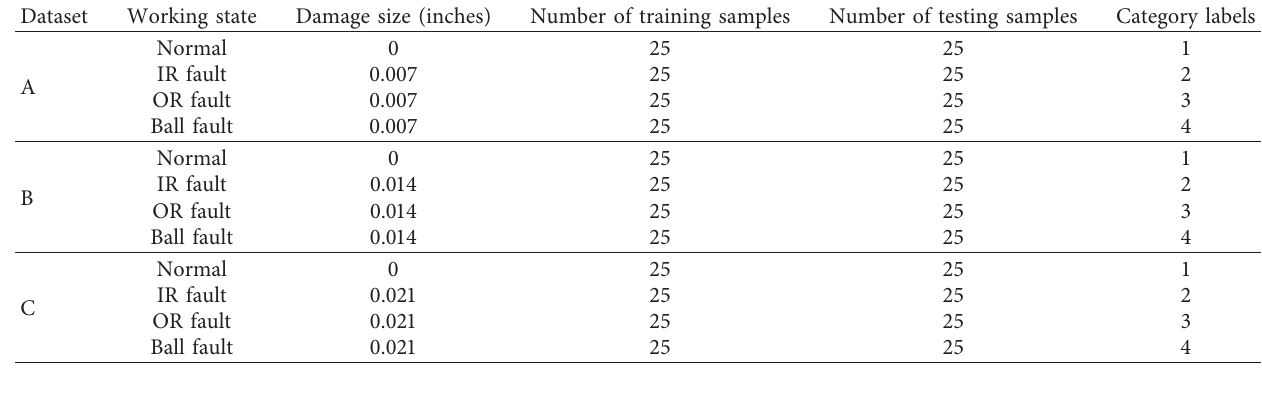
Table 5: Description of three datasets.